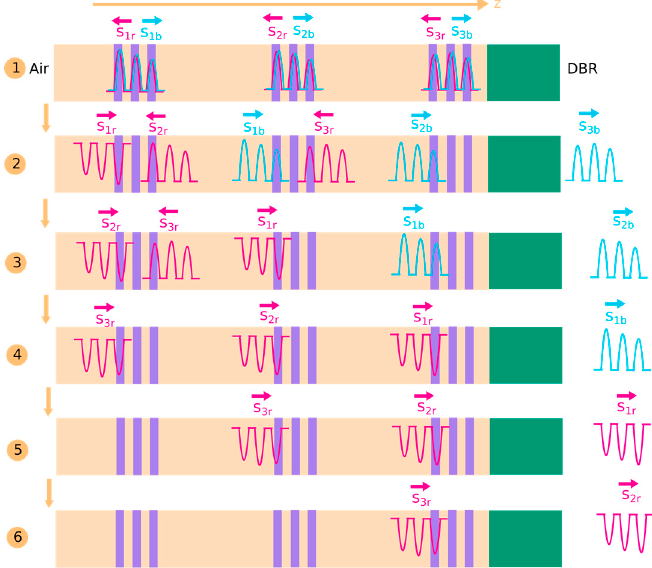
Figure 3. The illustration of the generation, propagation, and detection of acoustic stress bursts in the sample. Beige areas represent GaAs, violet areas represent QWs. Green area represents Al 0.95 Ga 0.05 As. S ir and S ib (i = 1, 2, 3) denote the backward and forward emitted from the i-th triple-QW stack stress bursts presented in red and blue colors, respectively.